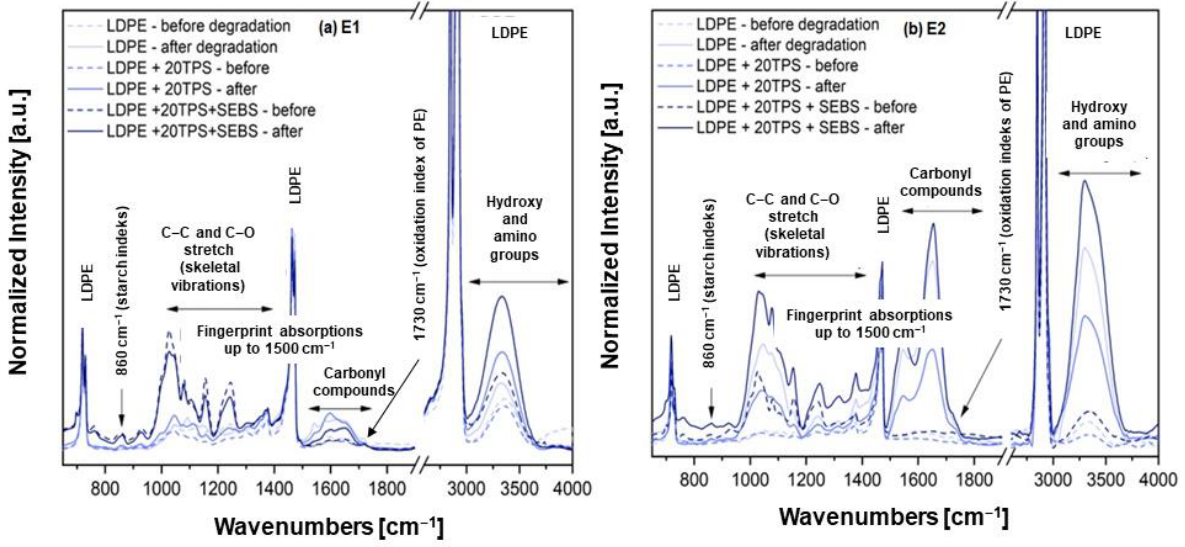
Figure 9. FTIR spectra of LDPE, LDPE+20 TPS, and LDPE+20 TPS+SEBS before degradation (dashed lines) and after degradation (full lines) in experiments ( a ) E1 and ( b ) E2.